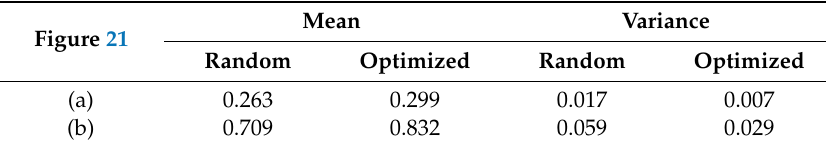
Table 16. Mean and variance of curves in Figure